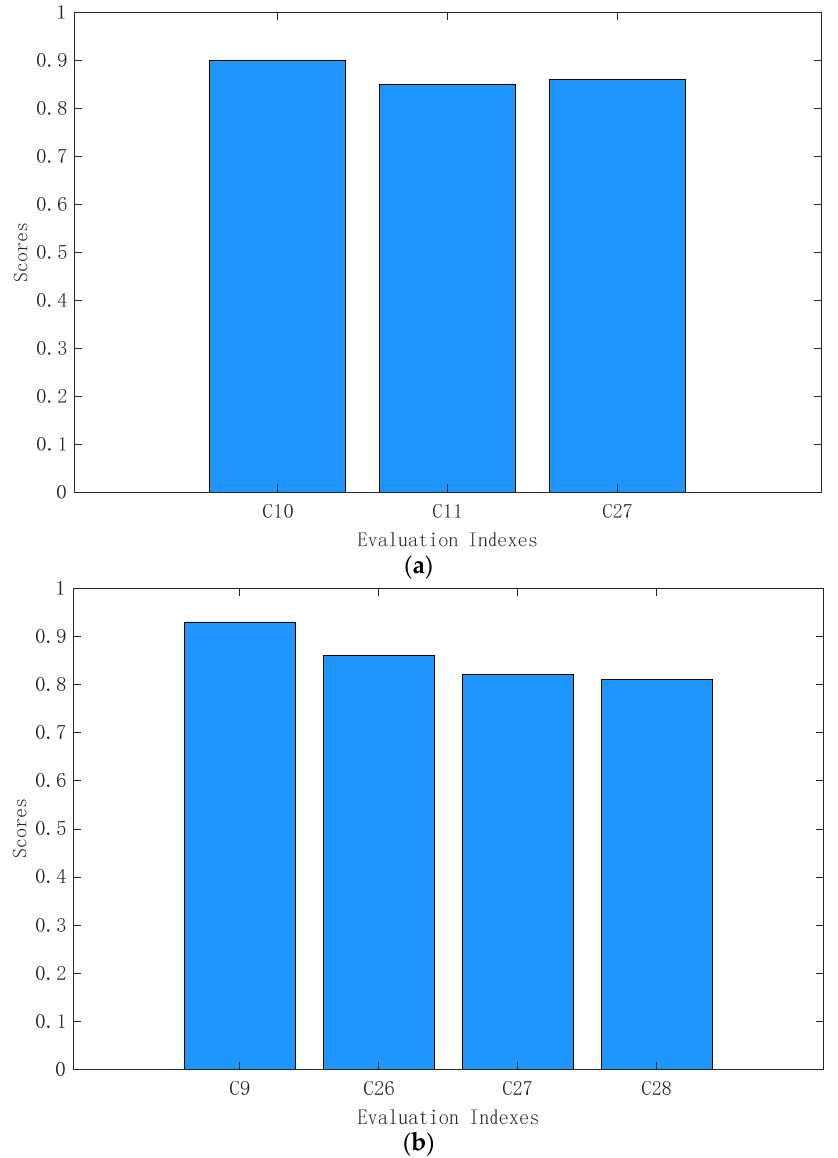
Figure 15. Each model anomaly indicator score after the optimization of the model optimization solutions: ( a ) model E 1 ; ( b ) model E 2 . Table 4. Reference table for the value of C 28